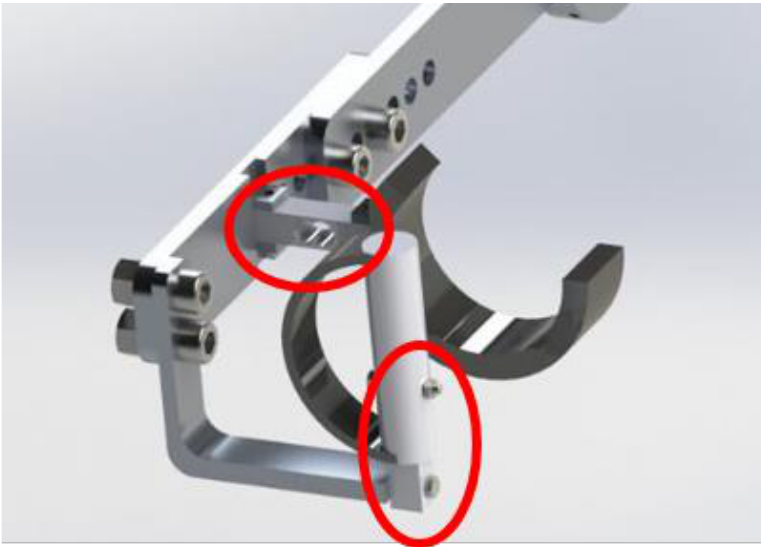
Figure 4. Locations of force sensors on the system